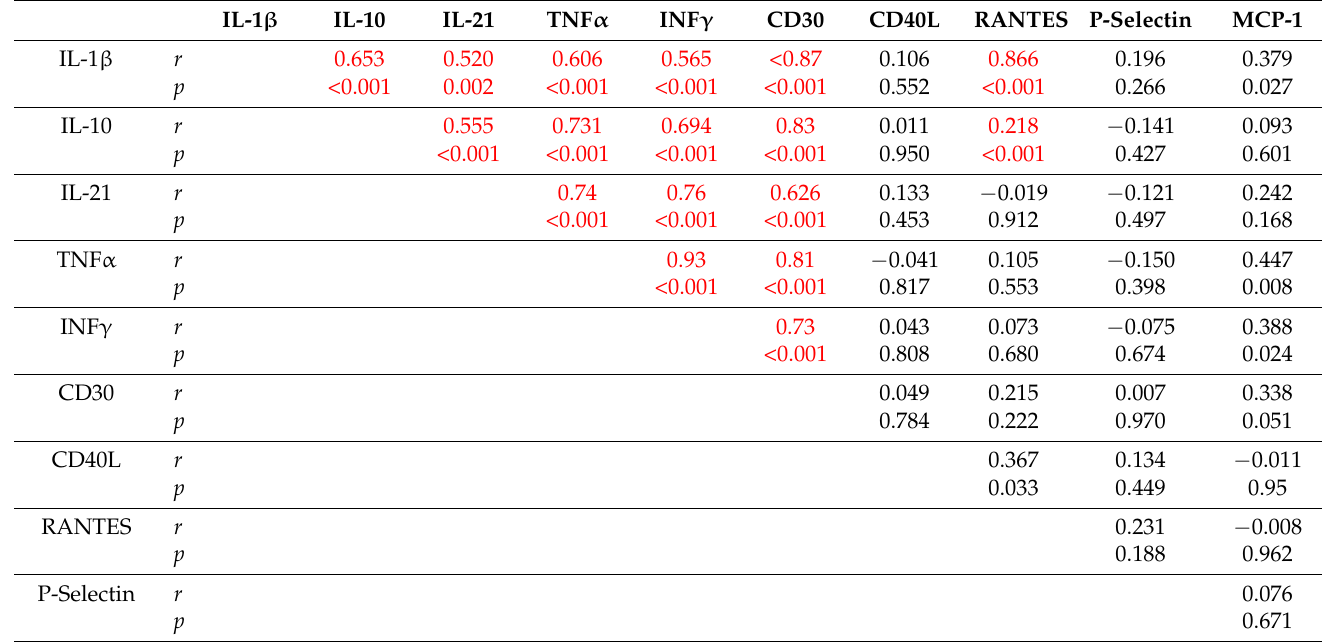
Table 4. Correlation between